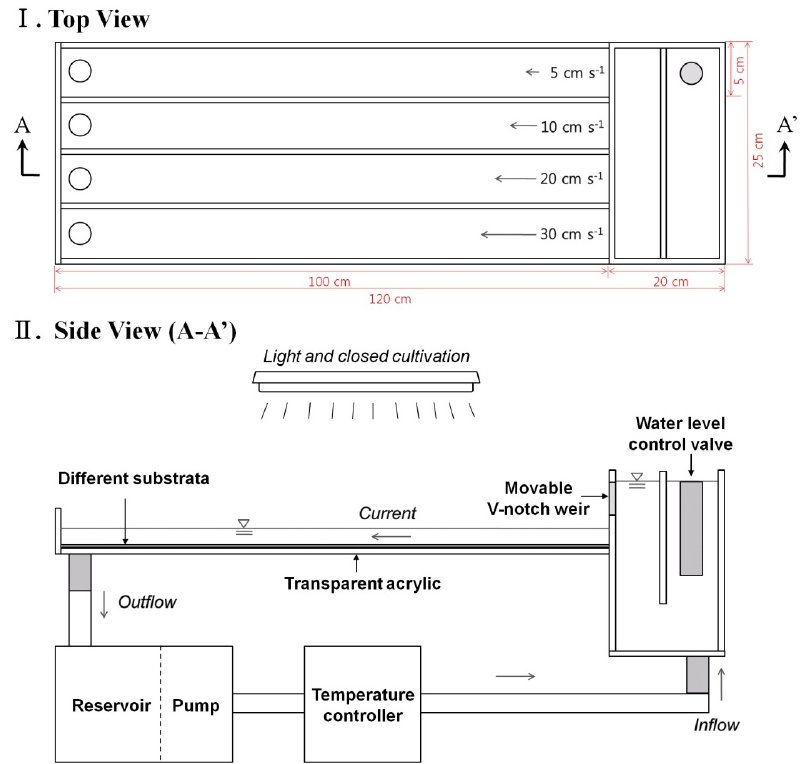
Figure 2. The artificial stream mesocosm apparatus used for periphyton